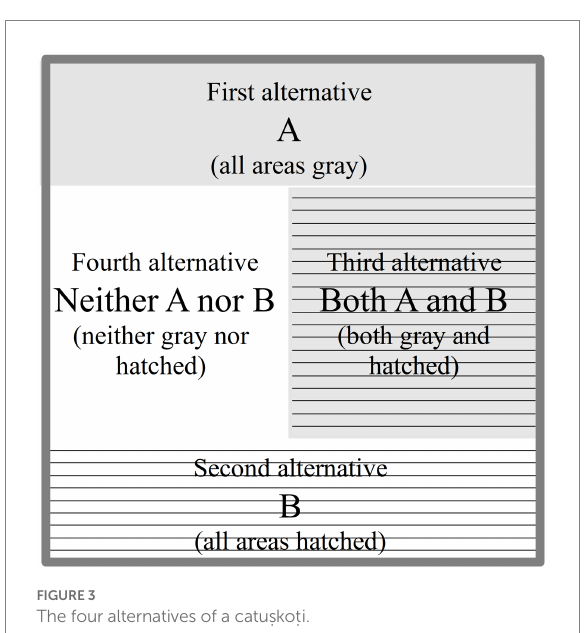
FIGURE 3 The four alternatives of a catus ̣ kot ̣ i.